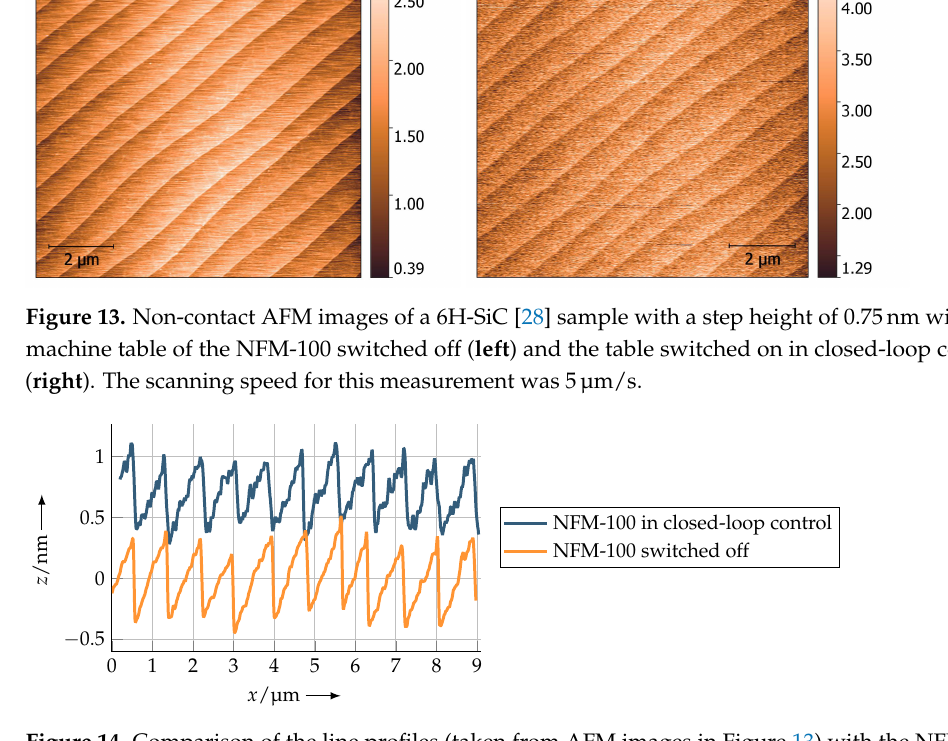
Figure 14. Comparison of the line profiles (taken from AFM images in Figure 13) with the NFM-100 switched on in closed-loop control and switched